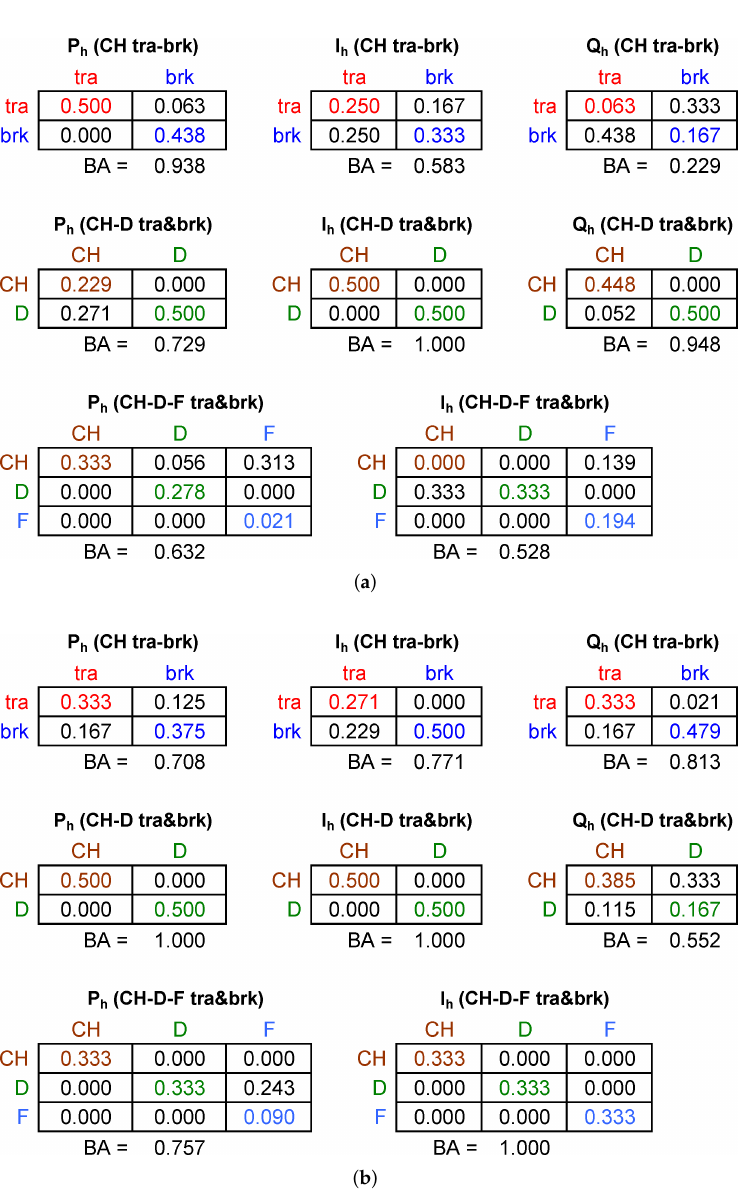
Figure 16. Confusion matrices and balanced accuracy BA for ( a ) PCA and ( b ) PLSR, using the k- means algorithm: 24 observations used for each rs (CH, D, and F train) and oc (traction and braking) for a total of 144 spectra; comparisons were carried out for traction/braking conditions within the same system (selected CH), for different rs for more similar systems (CH and D), and the same for all three different systems (CH, D, and